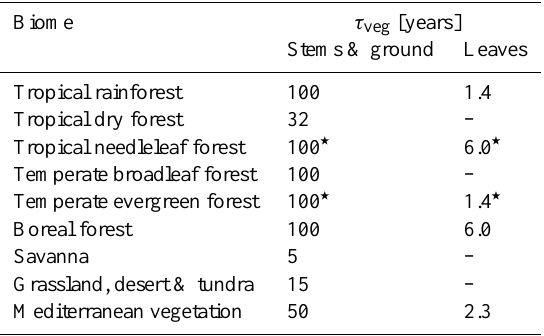
Table B3. Overview of the disturbance intervals τ veg of different biomes. The ? -symbol means that values from other biomes are used, since no original references could be found. A “–” in the column “Leaves” means that lichens and bryophytes cannot grow on the leaves of the respective vegetation type. The values are de- rived by calculating the median of a set of values from the literature. These are shown in Tables B4 and B5 below. Disturbance intervals for stems & ground are calculated as the minimum of the median of fire intervals, the median of treefall intervals and the herbivory interval, if present (see Tables B4 and